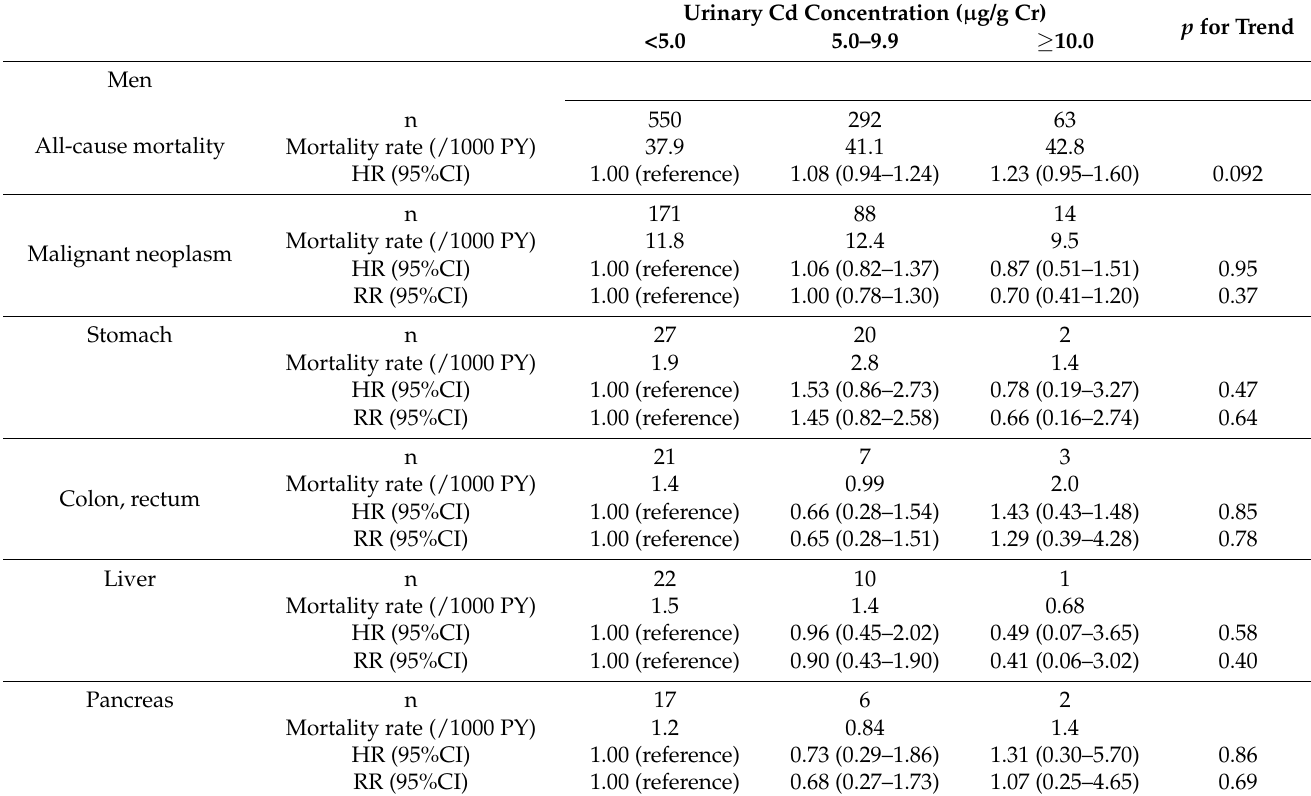
Table 3. Risk of all-cause mortality and cancer-specific mortality according to the urinary Cd concentration in the participants with a urinary β 2-MG level less than 1000 µ g/g